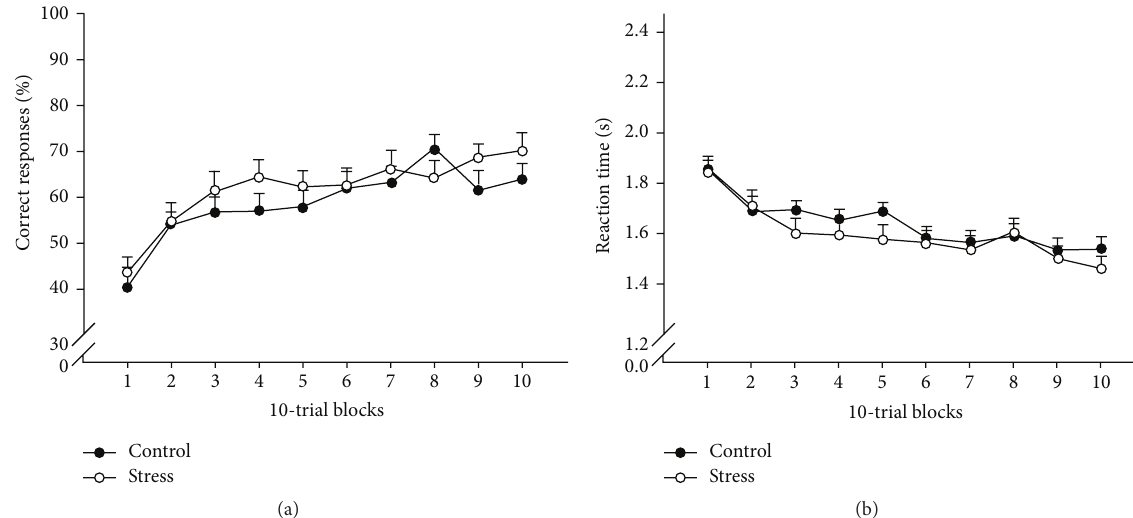
Figure 8: Comparable learning curves in the PCL task of the stress group and the control group: gradual improvement of classification performance across training. (a) Percentage of correct responses and (b) reaction time in seconds [79].